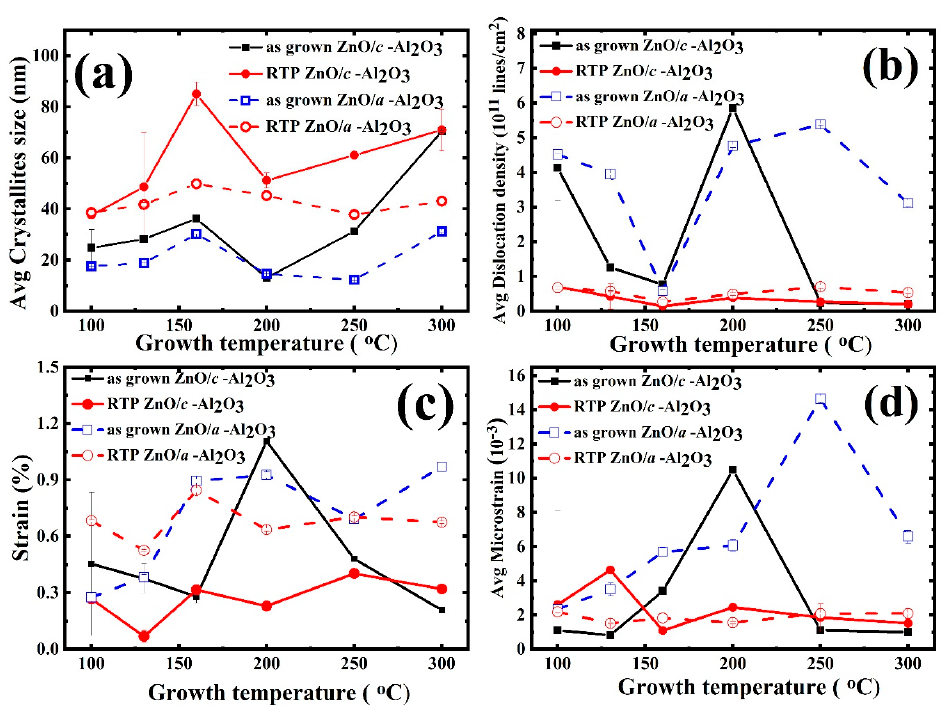
Figure 3. All microstructure parameter variations with T g : ( a ) crystallite size, ( b ) dislocation density, ( c ) strain%, ( d ) micro-strain, for as-grown and annealed ZnO films on c -Al 2 O 3 and a -Al 2 O 3 . (The dotted line is for guideline)